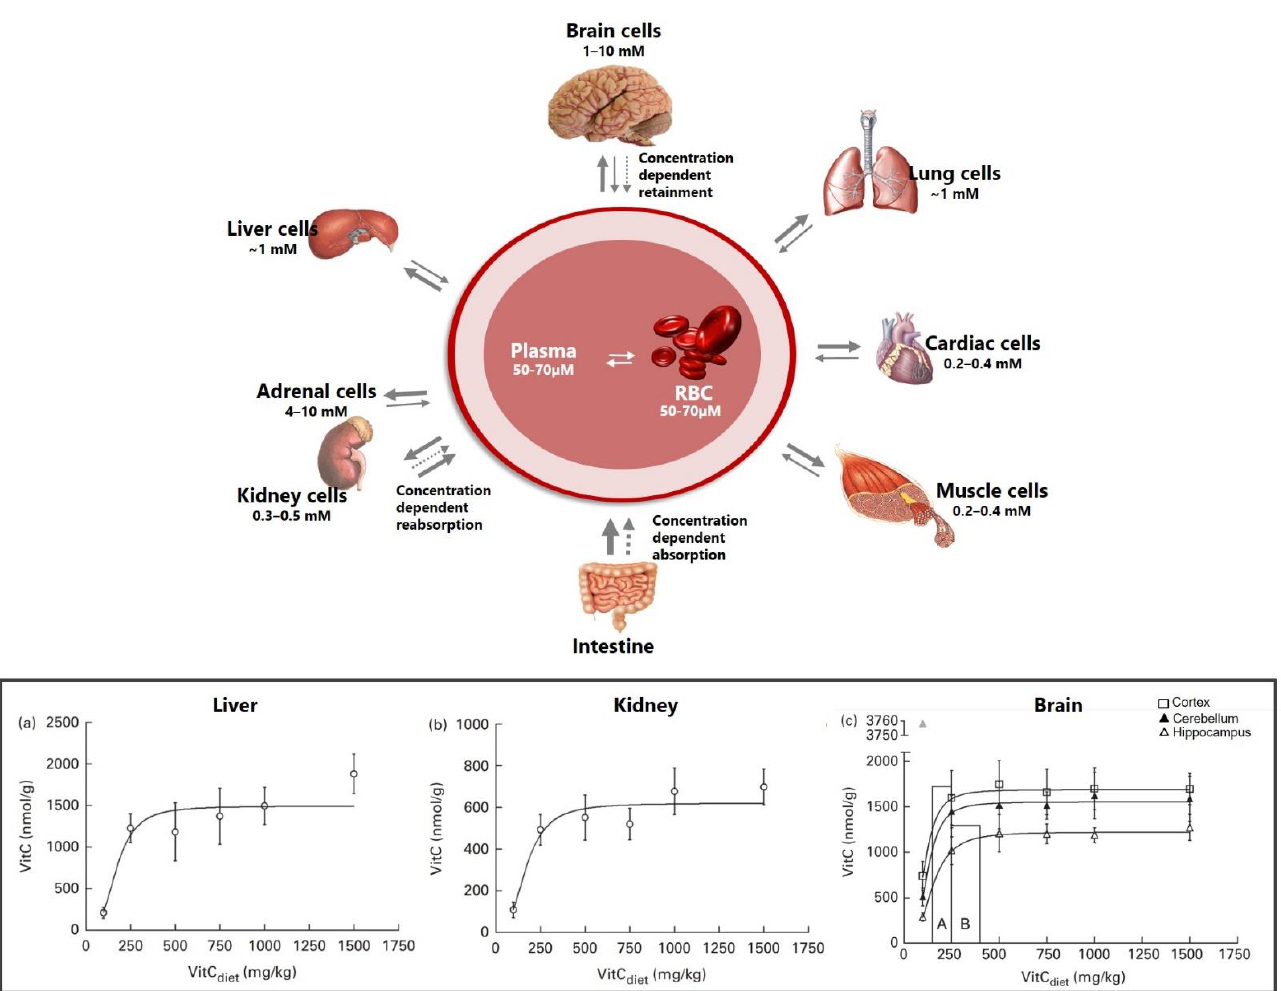
Figure 2. The distribution of vitamin C in the body. Distribution of vitamin C (vitC) in vivo is highly differential. Some organs have concentration-dependent mechanisms for retention of vitamin C, maintaining high levels during times of inadequate supply at the expense of other organs. In addition, the concentration-dependent absorption and re-absorption mechanisms contribute to the homeostatic control of vitC in the body. The brain upholds relatively high levels compared to other organs, with neurons displaying up to 10 mM. Inserted graphs show the dose–concentration curves measured in guinea pigs subjected to different dietary vitC doses, with estimated curve fitting (Hill equation); ( a ) liver, ( b ) kidney and ( c ) brain with cortex, cerebellum and hippocampus levels depicted individually. In the brain, the hippocampus achieves saturation (A) at a higher dose, but with a smaller concentration maximum (Cmax) compared to cortex and cerebellum (B), illustrating a regional difference in vitC distribution within the brain. In the liver and kidney, saturation is not as clear, suggesting a more direct reflection of the increasing plasma concentration compared to the brain. This supports that vitC transport to the brain is different from that of other organs and allows for the brain to be favored in vitC distribution. Moreover, the dose–concentration relationship underlines that accurate tissue levels of vitC are difficult to extrapolate from plasma levels. (Reproduced and modified from [28,73] and in accordance with CC by 4.0.).